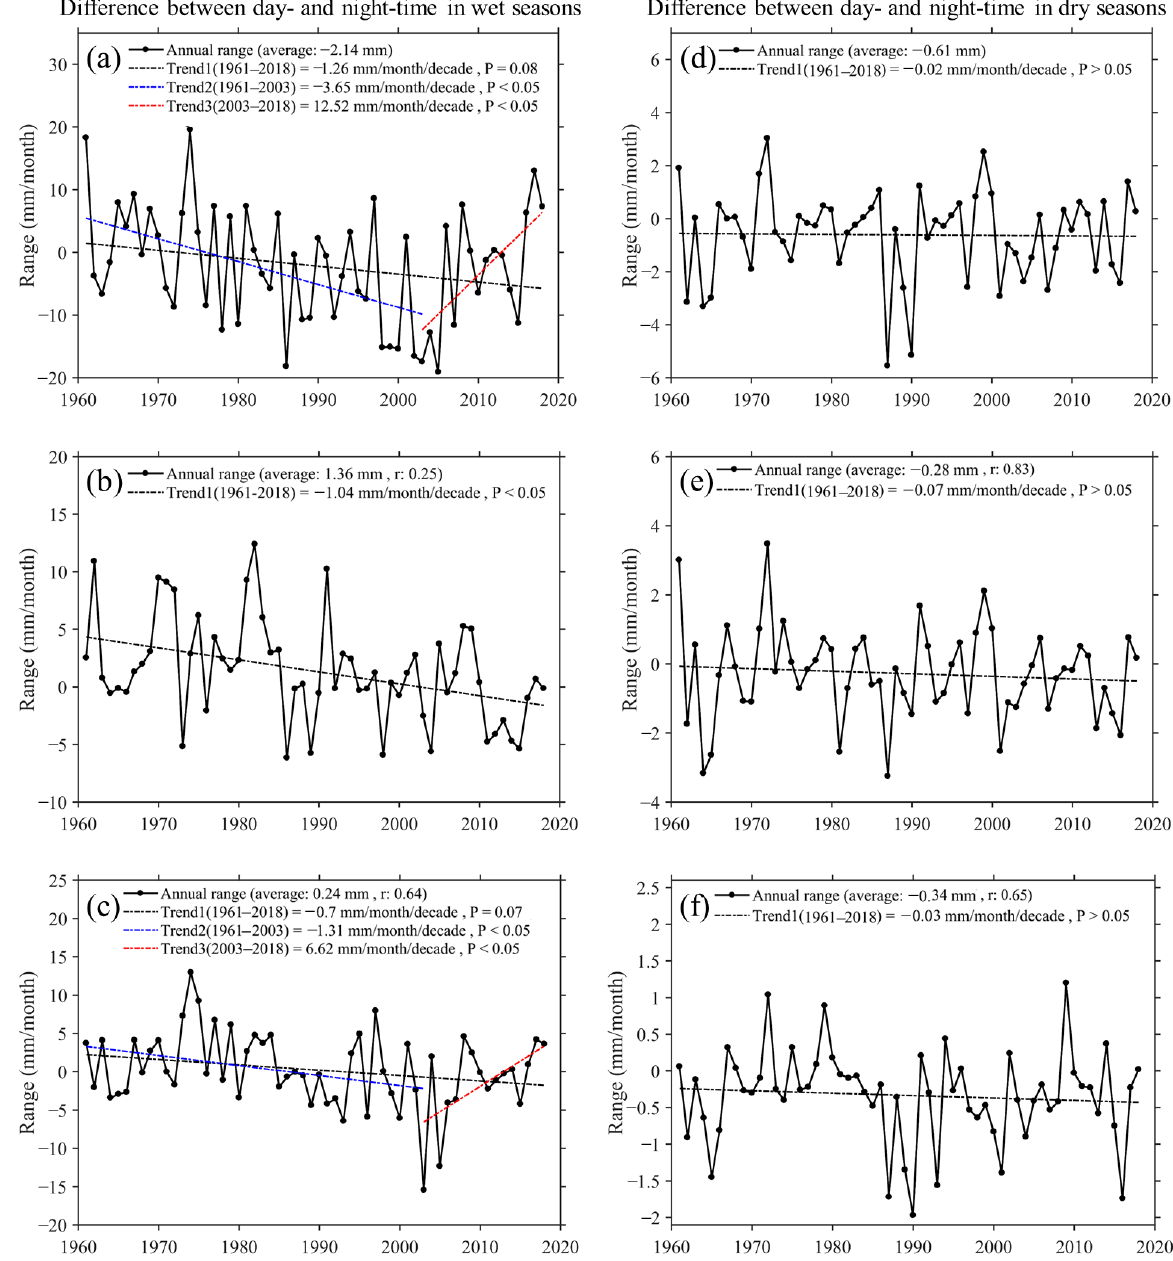
Figure 6. ( a ) Annual ranges of precipitation differences between daytime and nighttime during the wet seasons, ( b ) Annual ranges of large-scale precipitation (ERA5CON) differences between daytime and nighttime under wet season conditions using observed precipitation. ( c ) Annual ranges of convective precipitation (ERA5CON) differences between daytime and nighttime under wet season conditions using observed precipitation. ( d − f ) The same as ( a – c ), but for the dry seasons. The r denotes the correlation coefficient with the observed value (annual